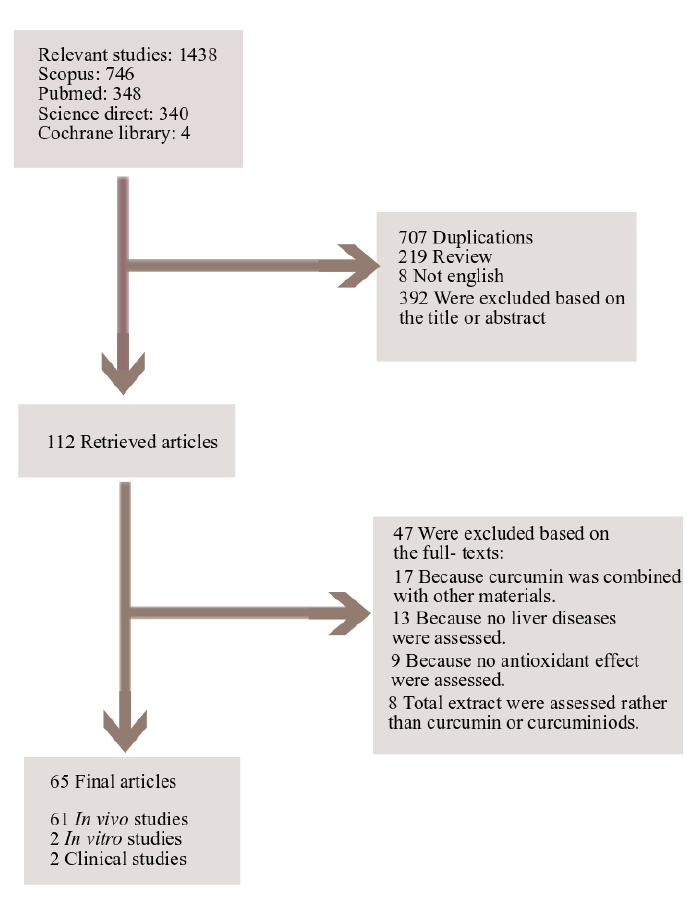
Figure 1. Study selection diagram.